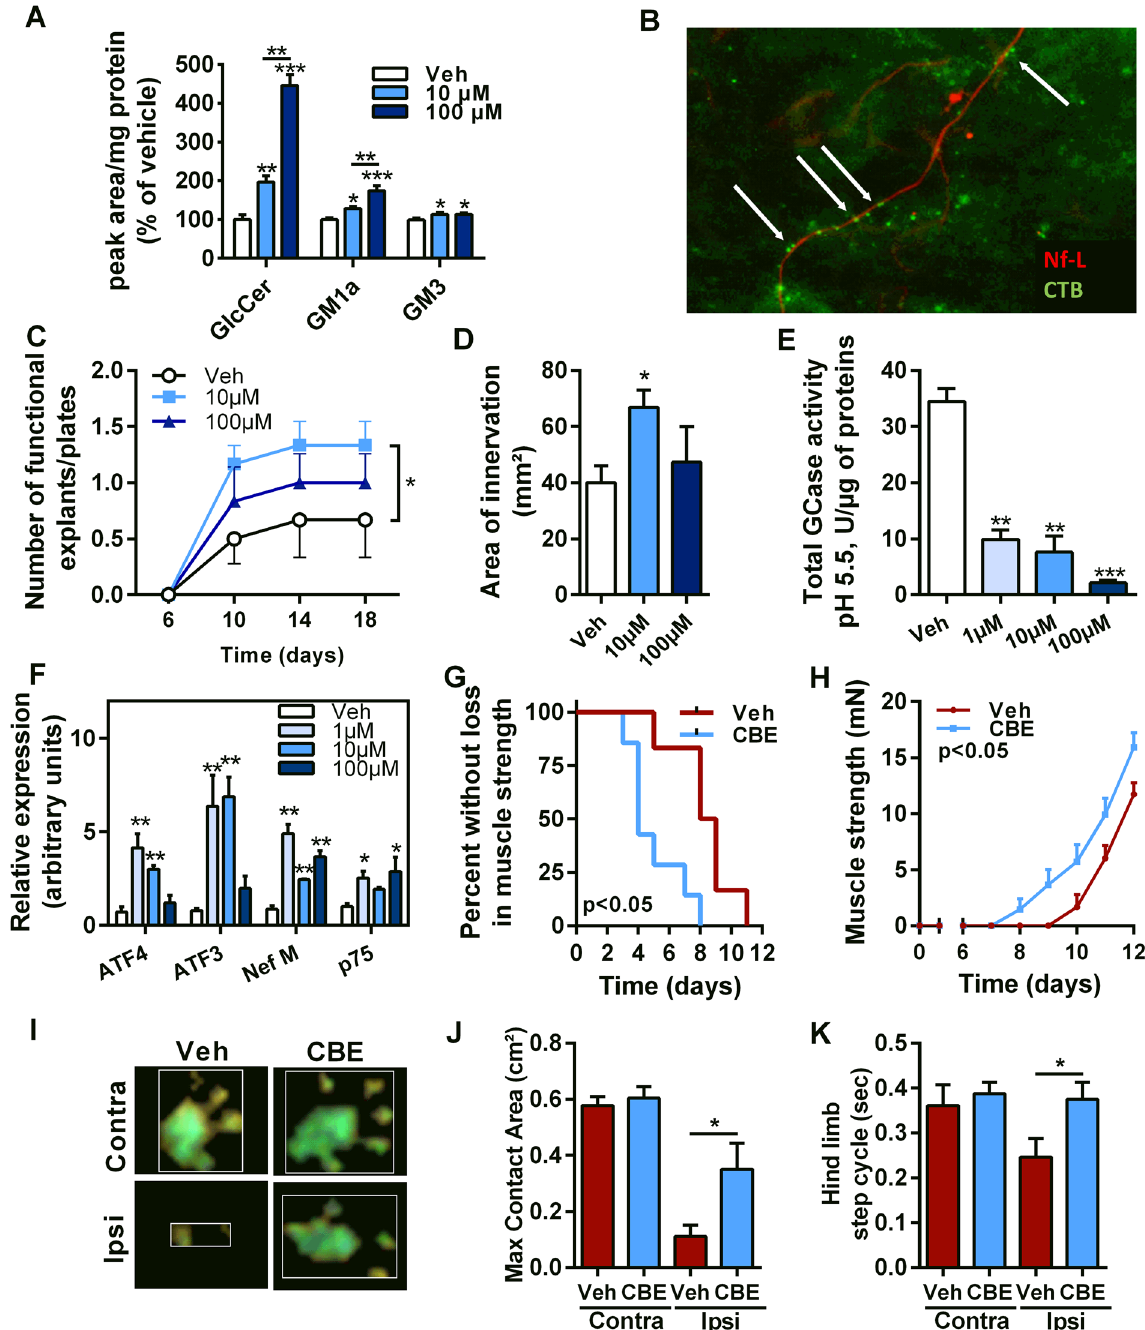
Figure 5. Inhibition of GlcCer degradation by CBE improves in vitro axonal plasticity and in vivo nerve regeneration. ( A ) Quantification of glycosphingolipids in the co-culture of muscle and spinal cord explants after CBE treatment. ( B ) Representative pictures for the distribution of neurofilament-L (red) and the cholera toxin subunit B (CTB, green) in the co-culture. Arrows indicate CTB-positive structures along an axon. ( C ) Given is the number of functional explants per culture plate identified by the presence of contraction of muscle fibres (n = 6). ( D ) Total area of innervation of functional explants after differentiation (n = 8/group). ( E ) Total GCase activity in PC12 cells after treatment with various doses of CBE (n = 3/group). ( F ) Transcriptional regulation of markers for neuronal differentiation in PC12 (n = 3/group). ( G ) Kaplan-Meier showing time to observable toe spreading after sciatic nerve injury (n = 7/group). ( H ) Muscle strength of ipsilateral hind paws, after sciatic nerve injury (n = 7/group). ( I ) Representative pictures for the areas of hind limb paws in contact with the ground. ( J , K ) Maximal contact area ( J ) and step cycle ( K ) of hind paws as determined by automated gait analysis. Mean + / − SEM; * p < 0.05; ** p <